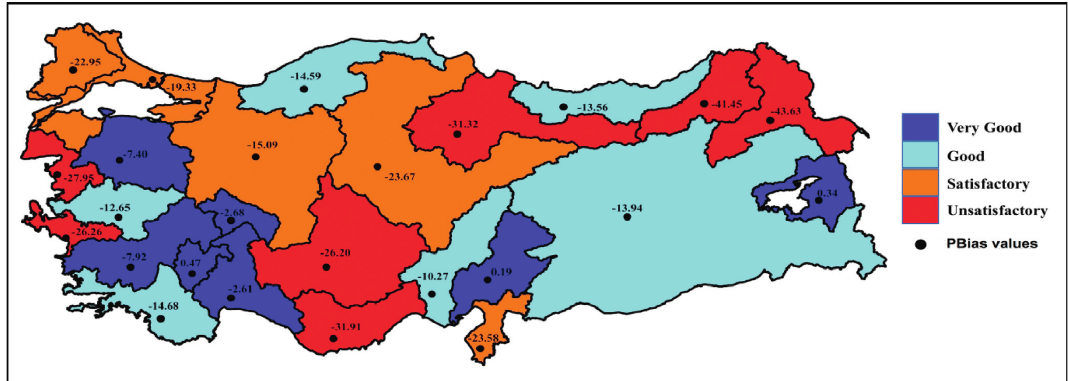
Figure 7: Results of PBias evaluation for CFSR data.